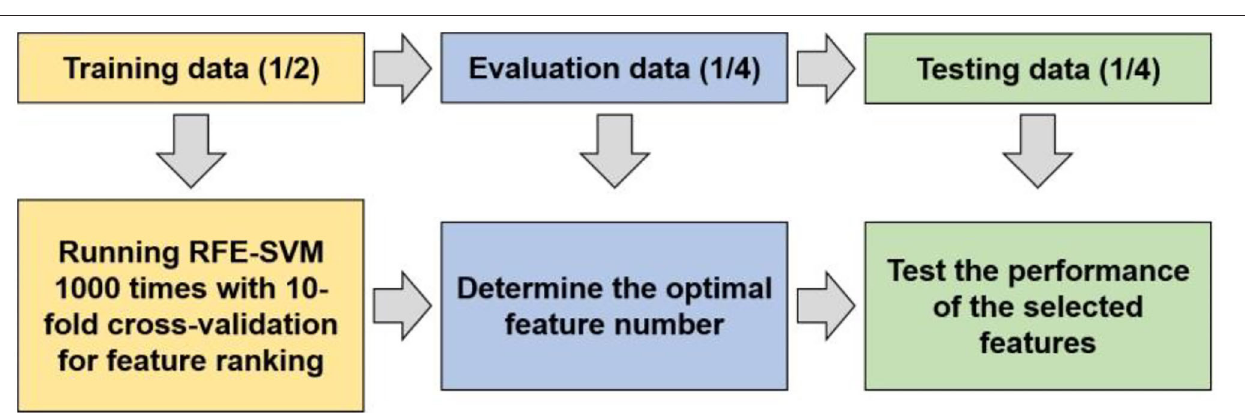
FIGURE 1 | The flowchart of data processing.